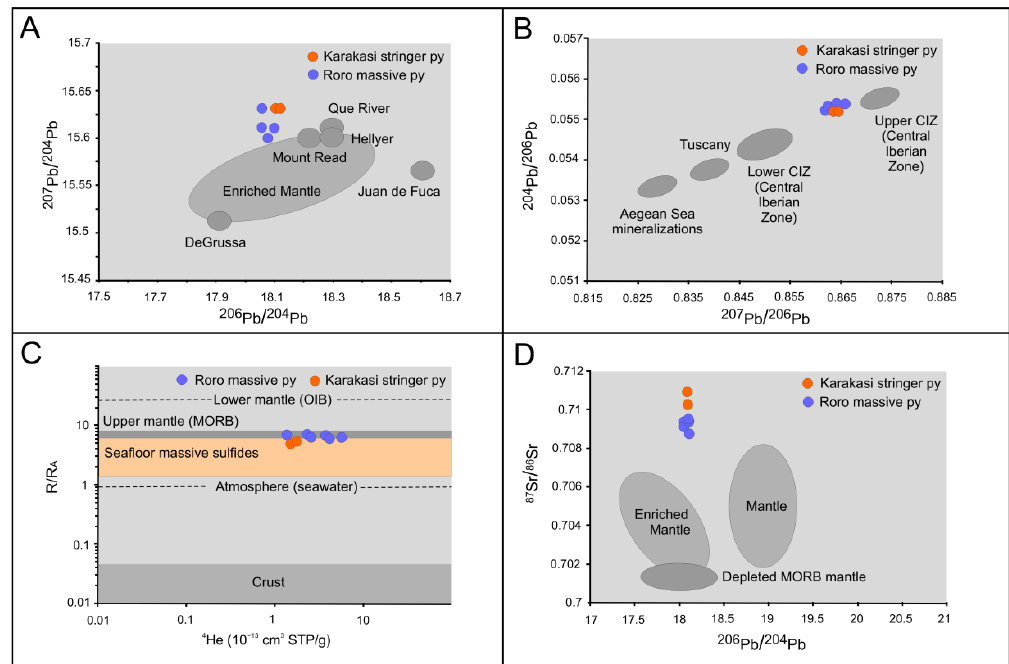
Figure 3. Radiogenic isotope binary diagrams for massive and stringer pyrite from Roro and Karakasi VMS, respecitvely. ( A ) 206 Pb/ 204 Pb vs. 207 Pb/ 204 Pb binary diagram of Ermioni VMS pyrite (data from [20,86–89]). ( B ) 207 Pb/ 206 Pb vs. 204 Pb/ 206 Pb binary diagram of Ermioni VMS pyrite (data from [75,89] and references therein). ( C ) 4 He vs. R/R A binary diagram of Ermioni pyrites. The light orange shaded area depicts the range of R/R A and 4 He values of seafloor massive sulfides (data from [79]).( D ) 206 Pb/ 204 Pb vs. 87 Sr/ 86 Sr binary diagram of Ermioni pyrites and silicic inclusions (fields from [87]).